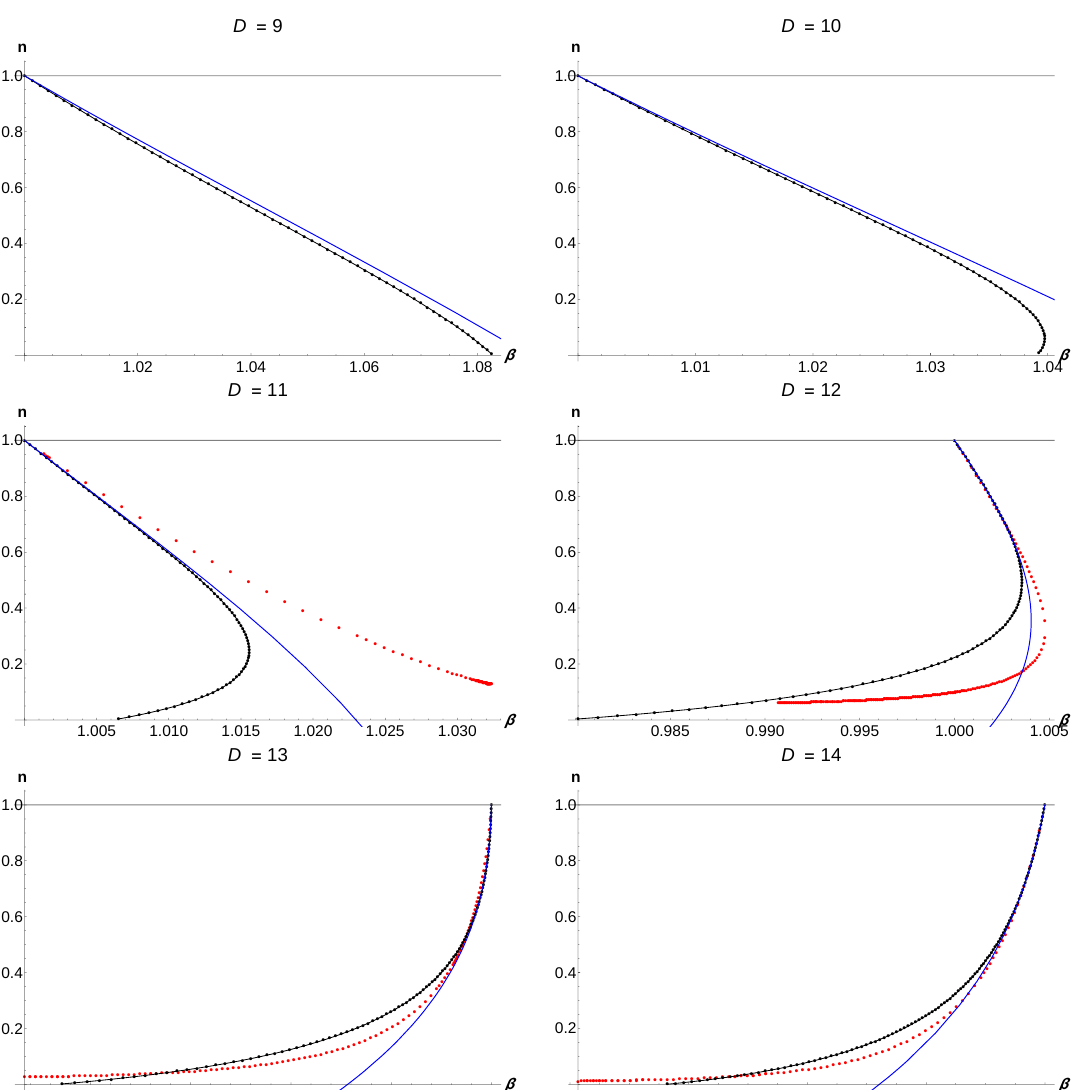
Figure 7 . Relative binding energy n (tension per unit mass and length) vs. inverse temperature (cid:12) . Black dots: large- D numerical results for NUBS. Blue solid: large- D perturbative solution for NUBS. The line n UBS = 1 corresponds to uniform black